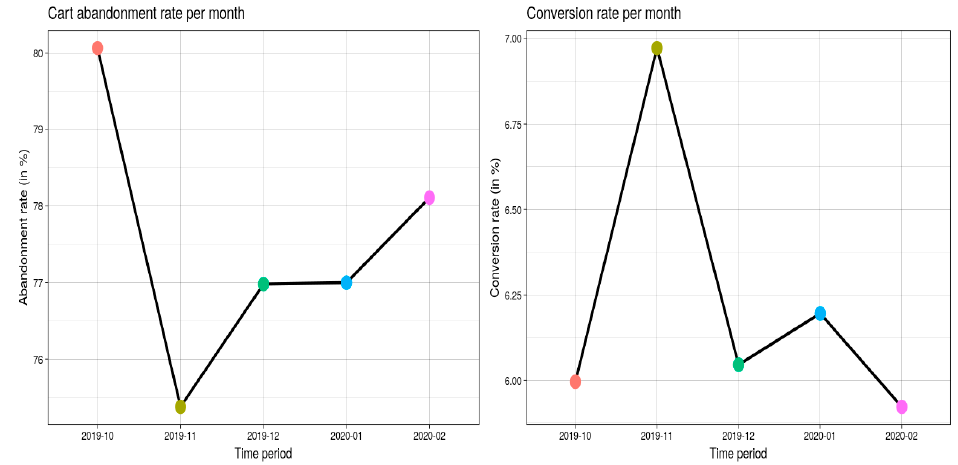
Figure 8. Total conversion rate.